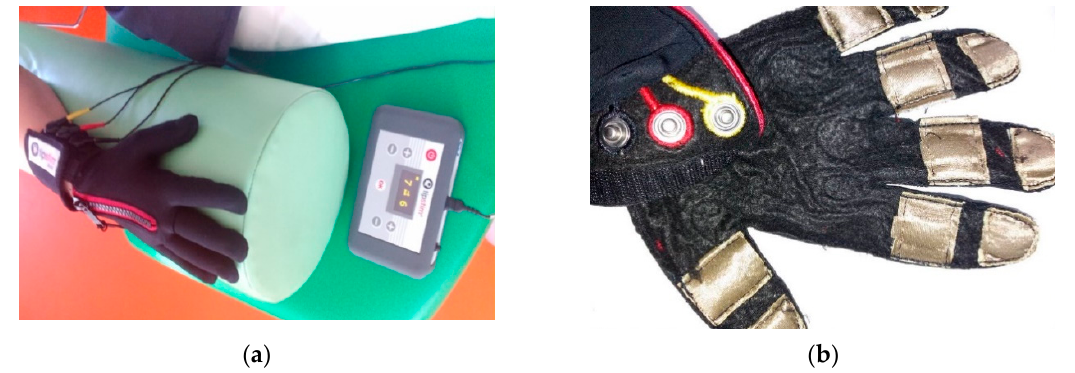
Figure 5. Electrostimulation therapy kit using the TipStim glove: ( a ) medical stand; ( b ) the internal view of stimulation glove.